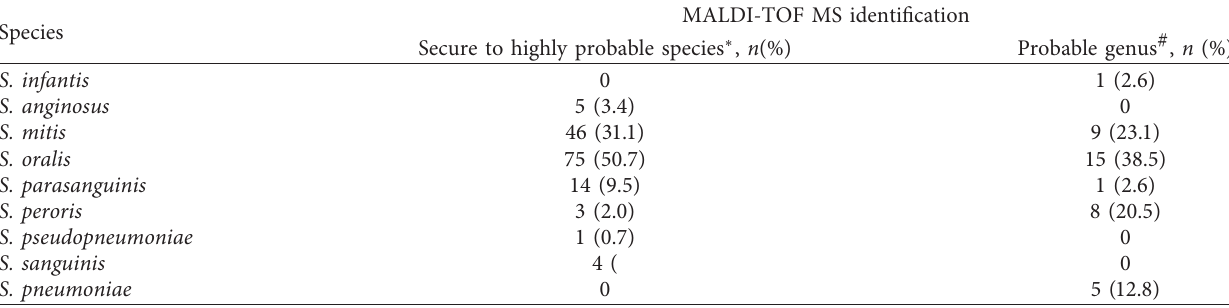
Table 1: MALDI-TOF MS identification for viridans group Streptococcus strains isolates from sputum samples of adult patients. Species